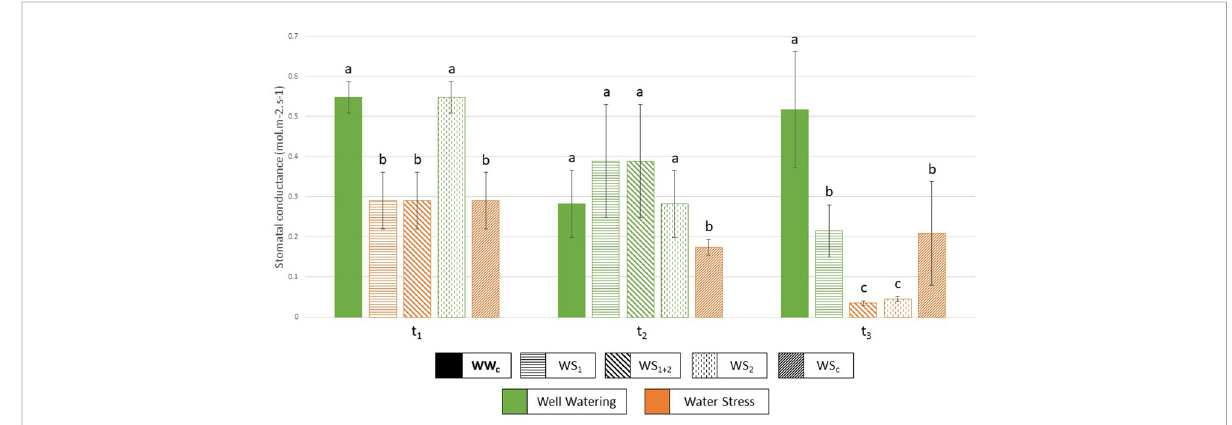
FIGURE 2 Stomatal conductance (mol.m – 2 .s – 1 ) measured at each harvest (t 1 , t 2 , t 3 ), and for each treatment. WW c, well-watered control plants; WS 1 , transient vegetative stress; WS 1+2 , recurrent stress, WS 2 , transient reproductive stress, and WS c , continuous stress. Green represents a well- watered period and orange, a water-stressed period. Values correspond to means ± SD ( n = 4 or n = 5), letters regroup treatment with a non- signi fi cant difference for each